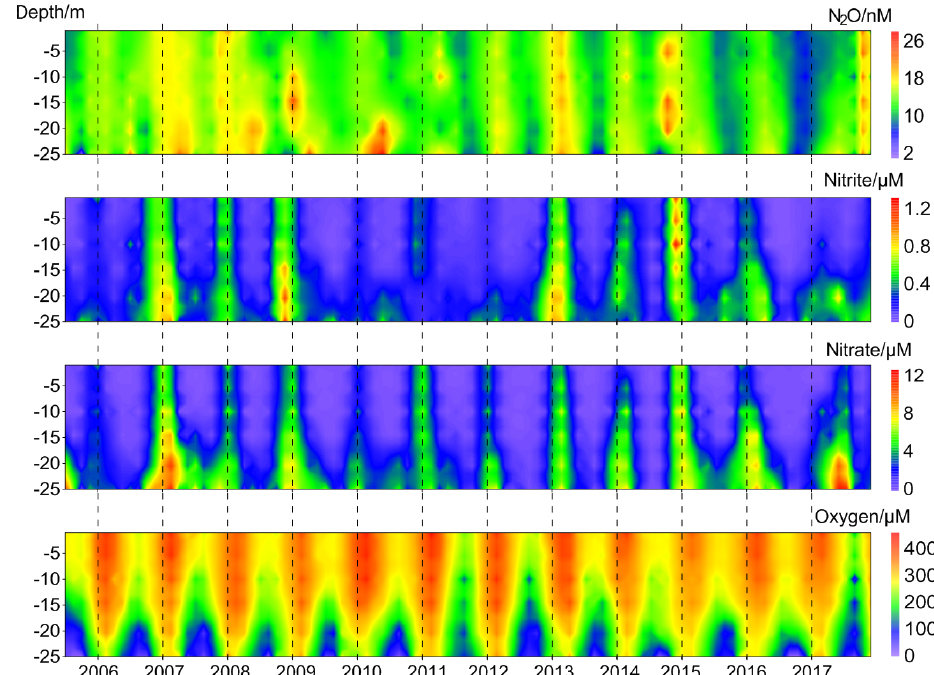
Figure 2. Vertical distributions of dissolved O 2 , NO −